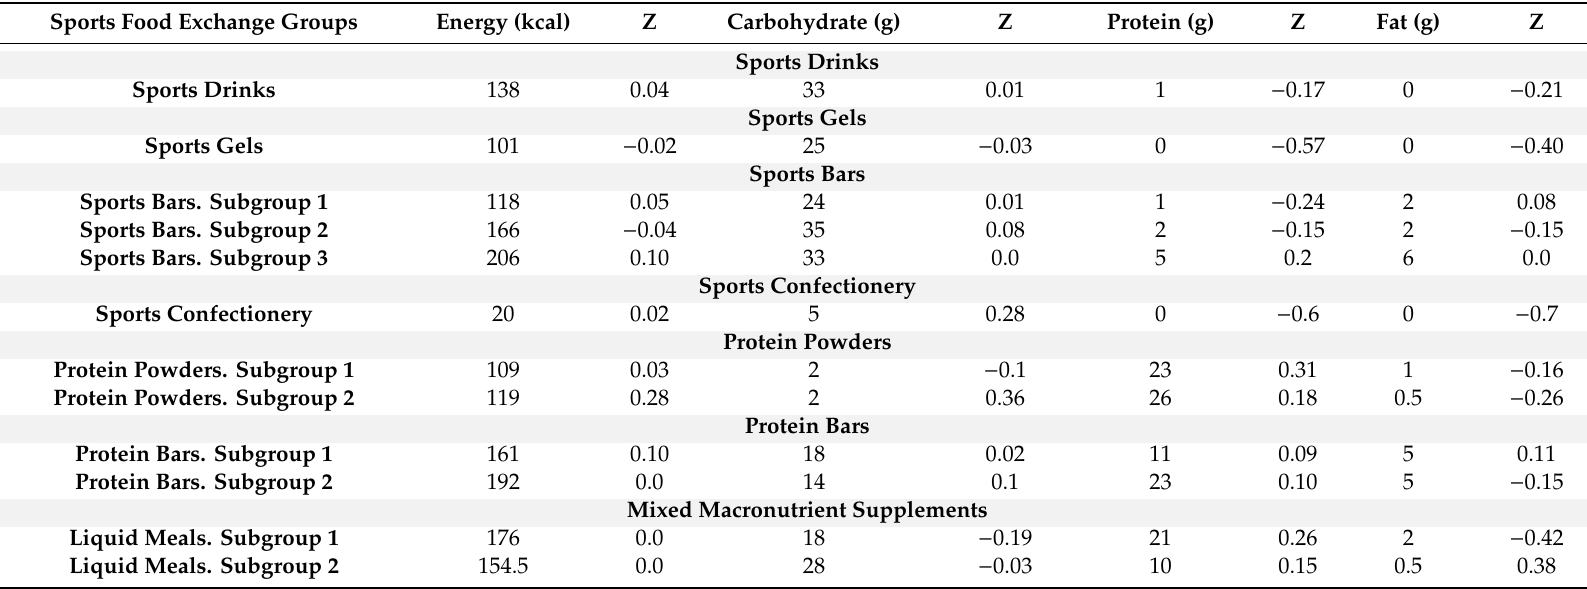
Table 5. Definitive exchange values of energy, macronutrients, and the Z value of the groups and subgroups proposed in the sports foods exchange list. Sports Food Exchange Groups Energy (kcal)